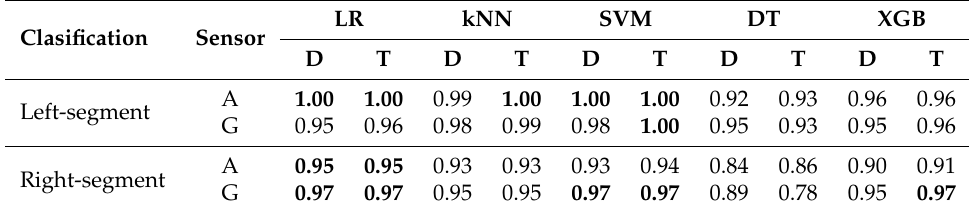
Table 4. Result of optimized classifiers for left-segment, right-segment classifications.